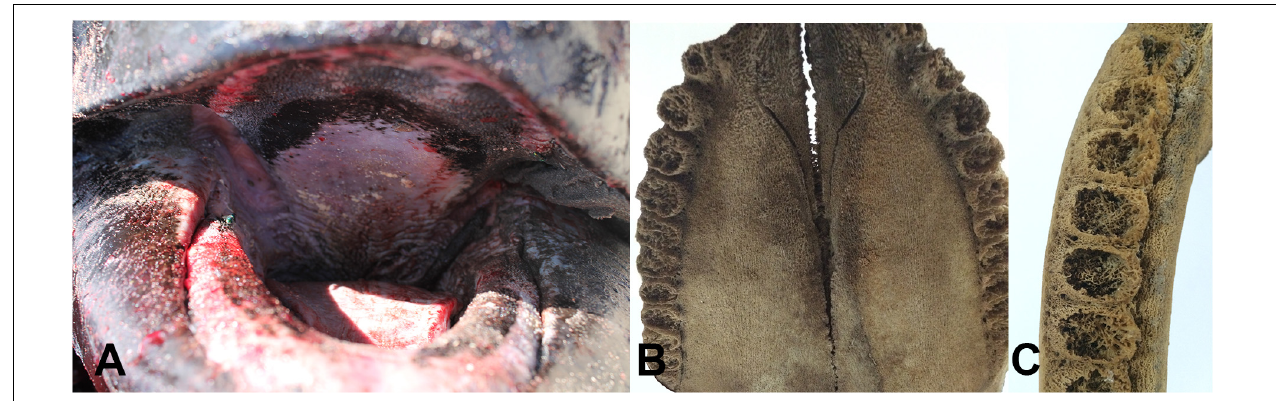
FIGURE 3 | Adult long-finned pilot whale ( Globicephala melas ) with complete edentulism and osteoporosis. (A) Oral cavity with lack of mandibular and maxillary teeth. (B) Dorsal view of the mandibular branch. (C) Closer view of the maxillary alveolar processes. Note the increased bone porosity with thin and irregular bone